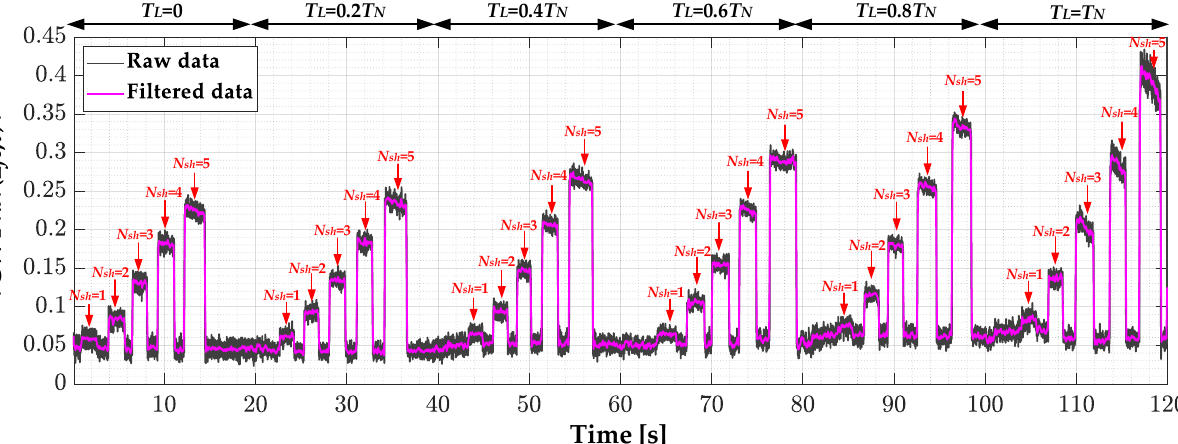
Figure 11. The raw and filtered waveforms of the |CWT |isA| (2 f s , t )| value during the cyclic momentary short-circuiting of 1 to 5 turns and different load torques levels ( T L = var, f s = f sN = 100 Hz). In order to make a final comparison of the sensitivity to stator winding fault of the extracted symptoms and to select those to be used as elements of the input vector of the ML models, Figure 12 shows the effect of T L and N sh on the value of their